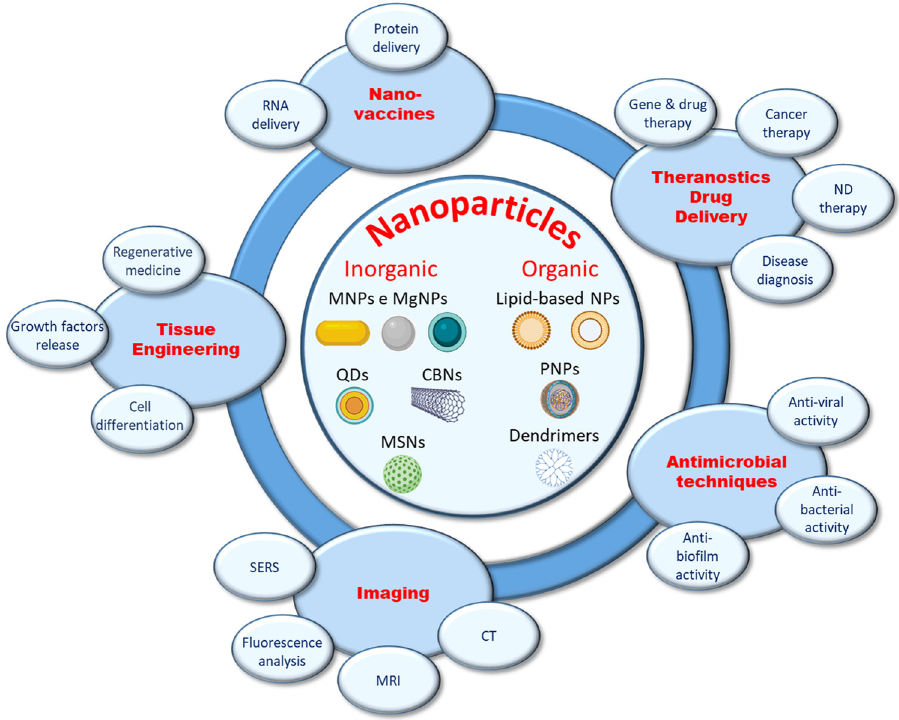
Figure 1: Nanoparticles classi fi cation and applications in biomedicine. Inorganic NPs include metal and magnetic NPs ( gold, silver, SPIONs ) , QDs, CBNs, and MSNs; organic NPs collect lipid - based NPs ( liposomes and micelles ) , PNPs and dendrimers. Depending on the material, size, shape, and functionalization, NPs can be employed in nano - vaccines both for protein and RNA delivery; theranostics drug delivery that include treatment and diagnosis of many pathologies like cancer and NDs; antimicrobial ( anti - viral, bacteria and bio fi lms ) techniques; imaging for CT, MRI, SERS, and fl uorescence analysis; tissue engineering in regenerative medicine for growth factors release or cell di ff